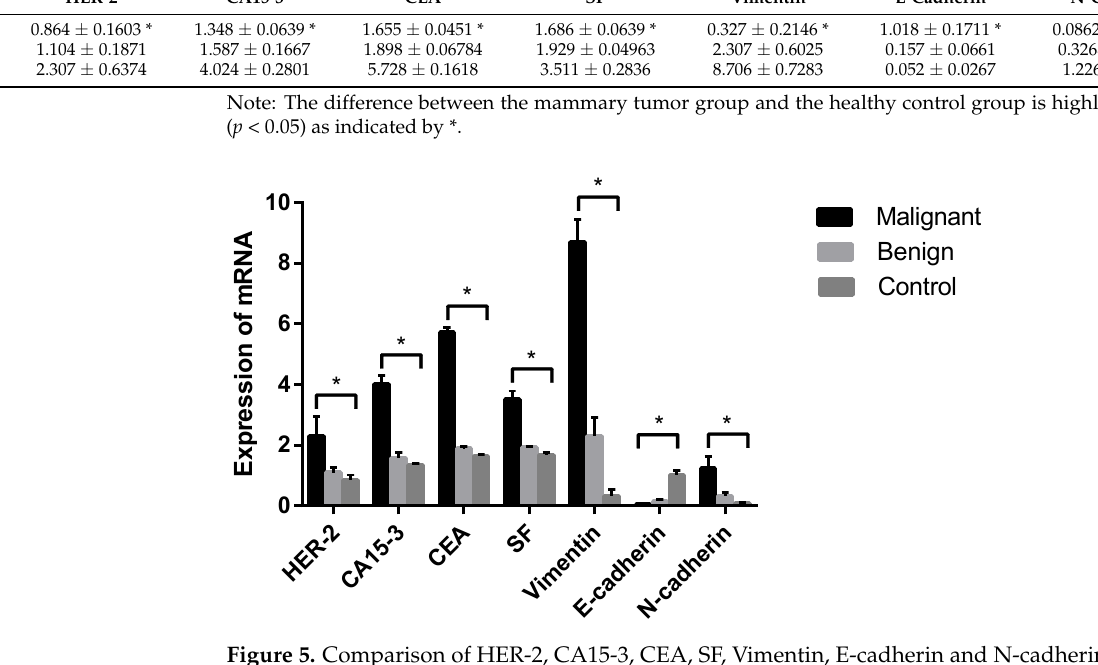
Table 6. The relative expression of HER-2, CA15-3, CEA, SF, Vimentin, E-cadherin and N-cadherin mRNA.